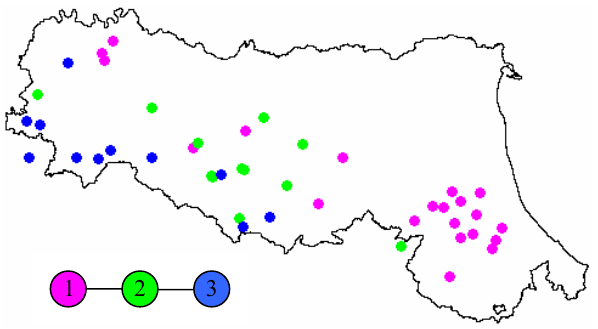
Fig. 4. Catchments of the 3-cluster classification identified by SOM based on streamflow signatures.